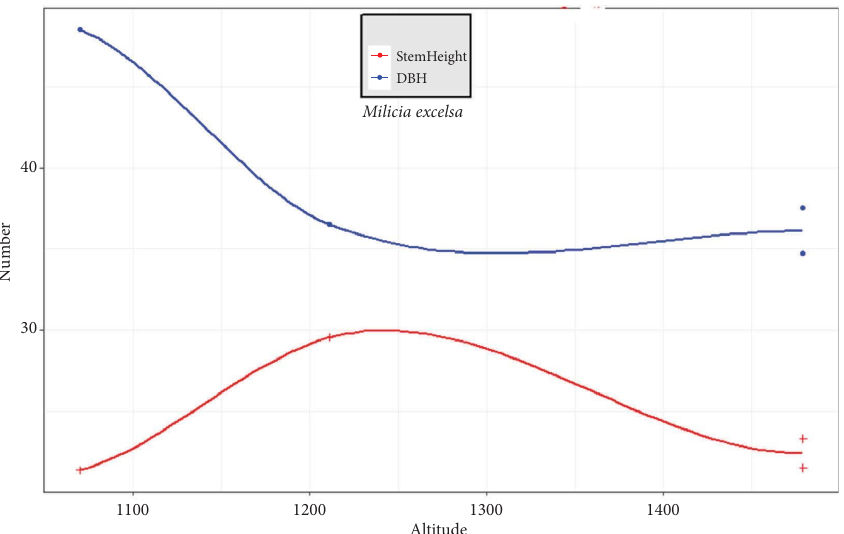
Figure 7: Distribution of stem height and dbh of M. excelsa along altitudinal gradients.